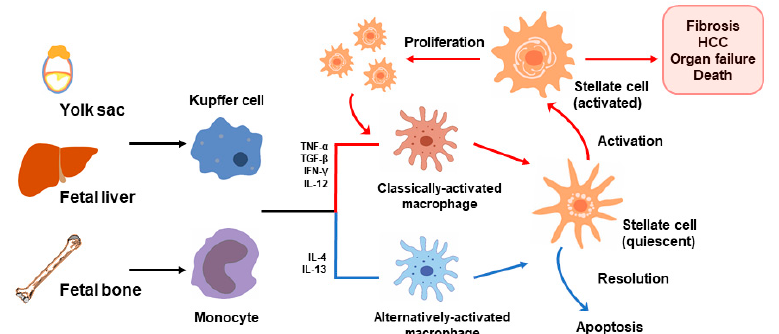
Figure 3. Bone-marrow-derived and liver resident macrophages in offspring from obese mothers have trained memories towards inflammatory phenotypes and secrete inflammatory and fibrogenic factors to induce hepatic stellate cell activation. Activated stellate cells undergo rapid proliferation to further worsen inflammation, ultimately leading to fibrosis, organ failure, and death. HCC, hepatocellular carcinoma.